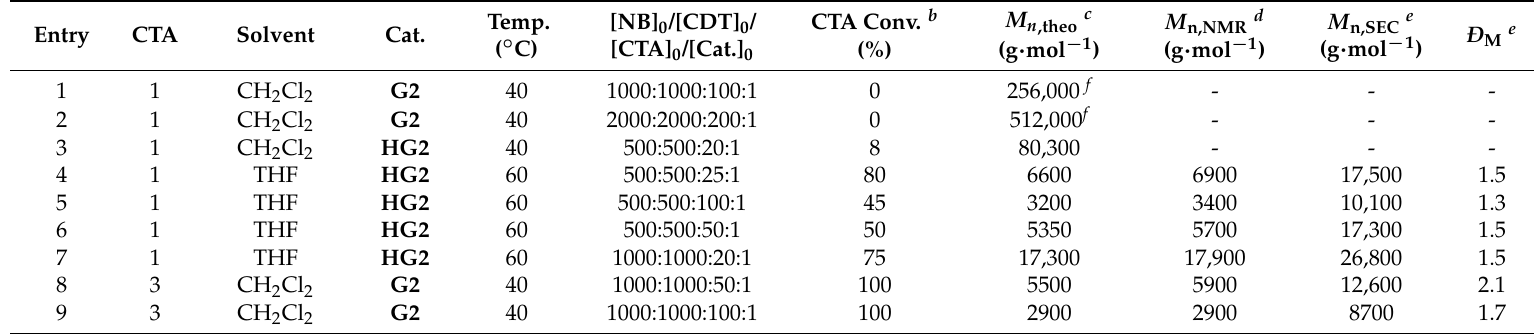
Table 3. ROMP/CM of equimolar mixtures of NB with CDT catalyzed by G2 or HG2 in the presence of CTA 1 or 3 in CH 2 Cl 2 or (CH 2 Cl) 2 at 40 or 60 ◦ C for 24 h a